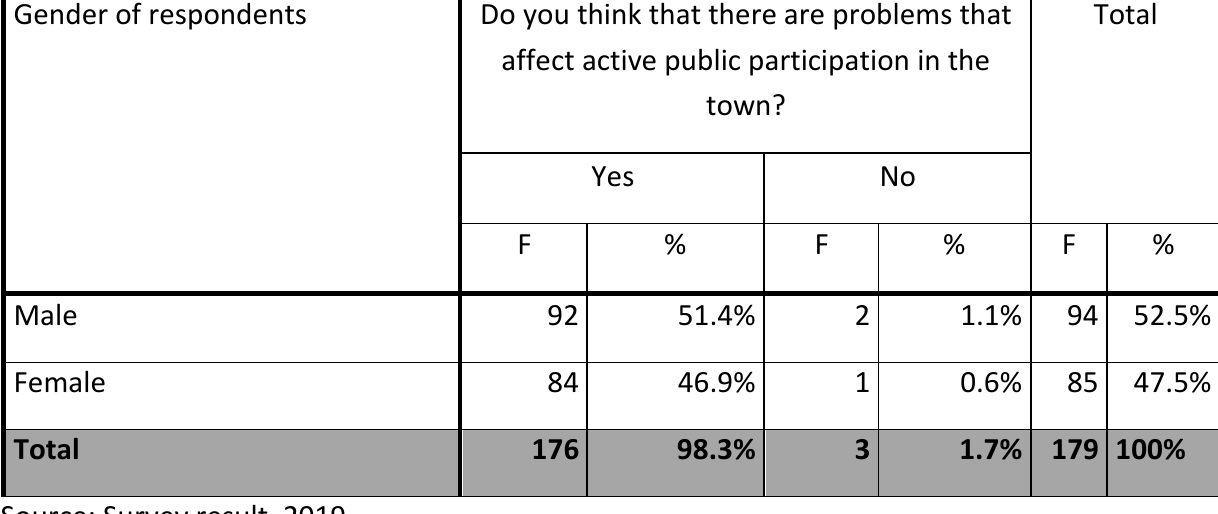
Table 11: Citizens were asked to offer opinions about problems that affect active public participation in the town administration in general Gender of